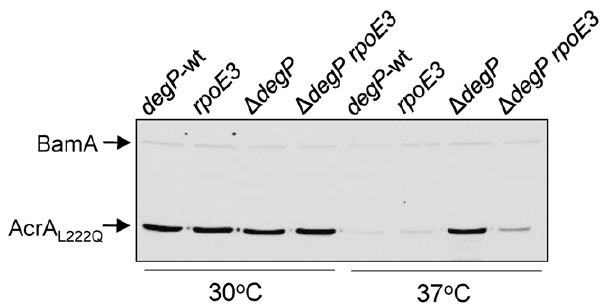
Figure 7. Levels of a labile AcrA variant, AcrA L222Q , in cells with various genetic backgrounds. Cultures were grown at 30 u C and 37 u C and AcrA L222Q levels were determined from whole cell extracts by Western blot analysis. BamA, detected by BamA antibodies, was used